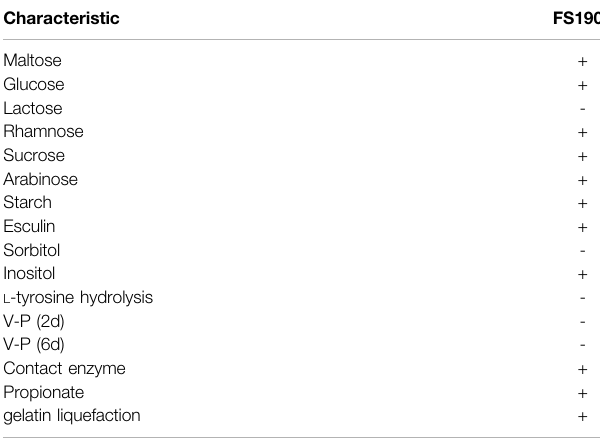
TABLE 1 | Physiological and biochemical characteristics of strain